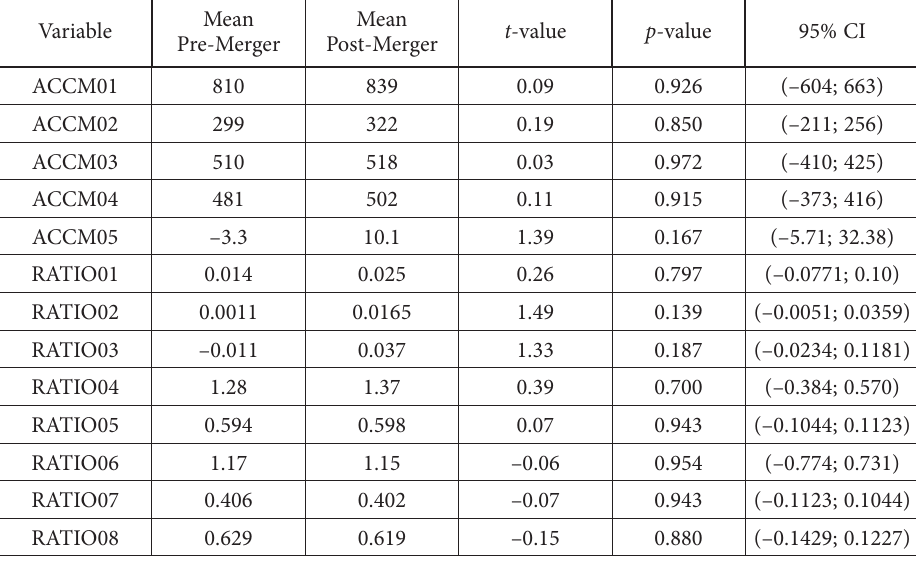
Table 5a. Comparison results (with mean) of mergers with pre- and post-analysis of the sample firms Variable